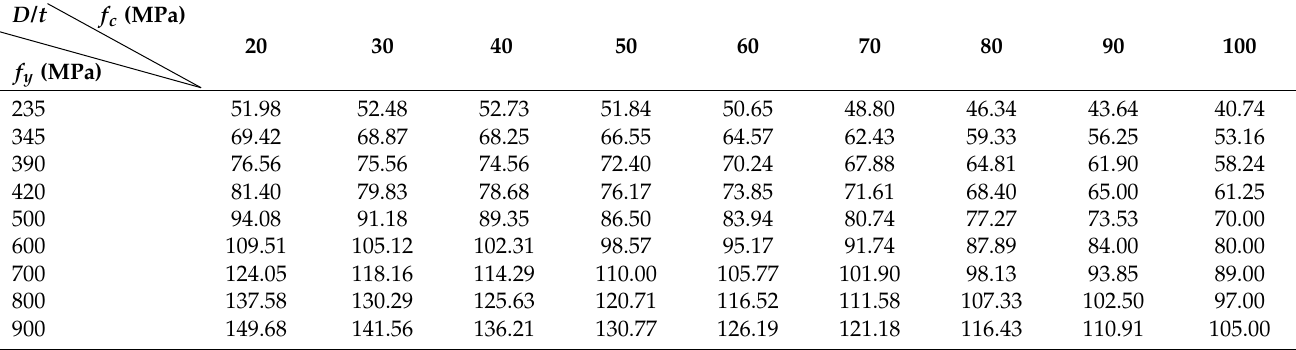
Table 2. Optimal D / t ratios corresponding to different material strength